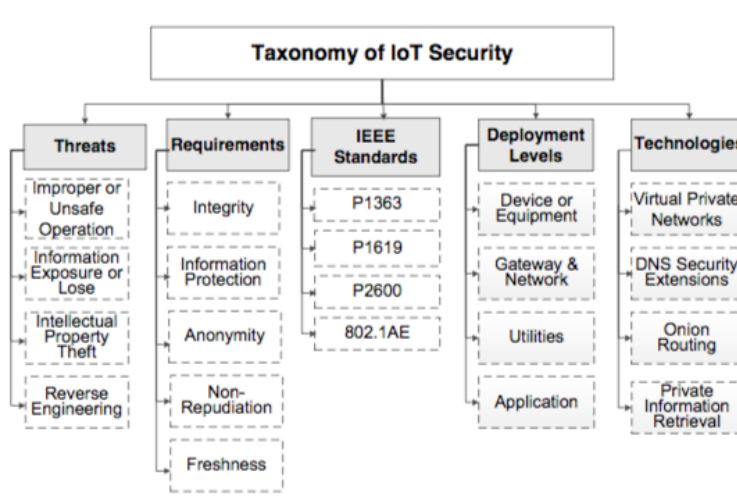
Figure 2: Taxonomy of IoT